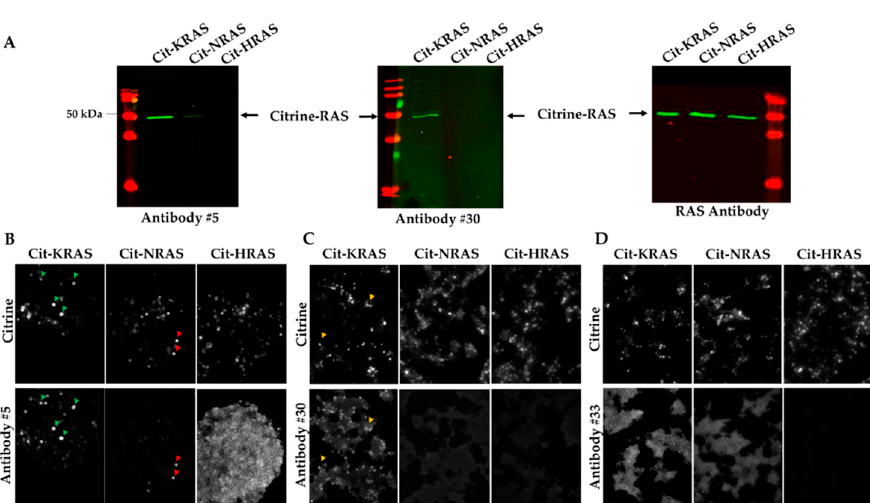
Figure 2. Validation of the specificity of KRAS antibodies by immunocytolabeling. ( A ) Western blots